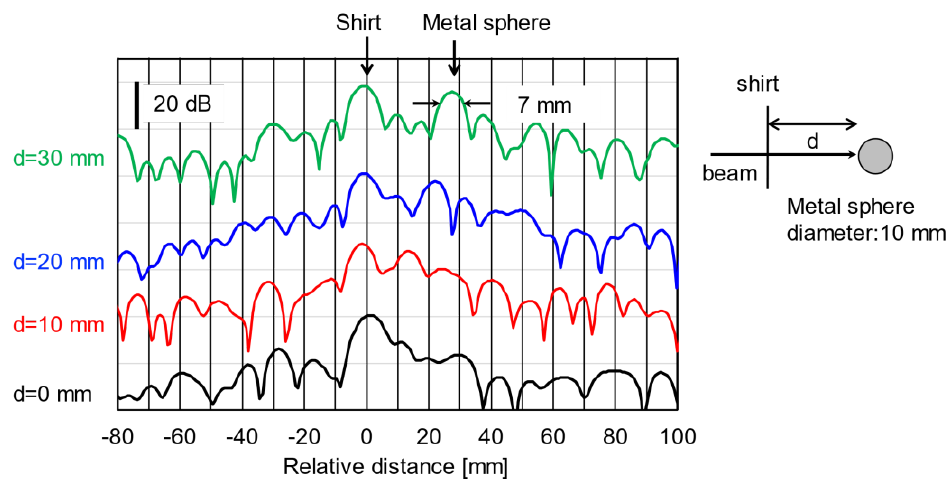
Figure 14. Range profile (power spectra) of a stretched shirt in front of a metal sphere at various separations.